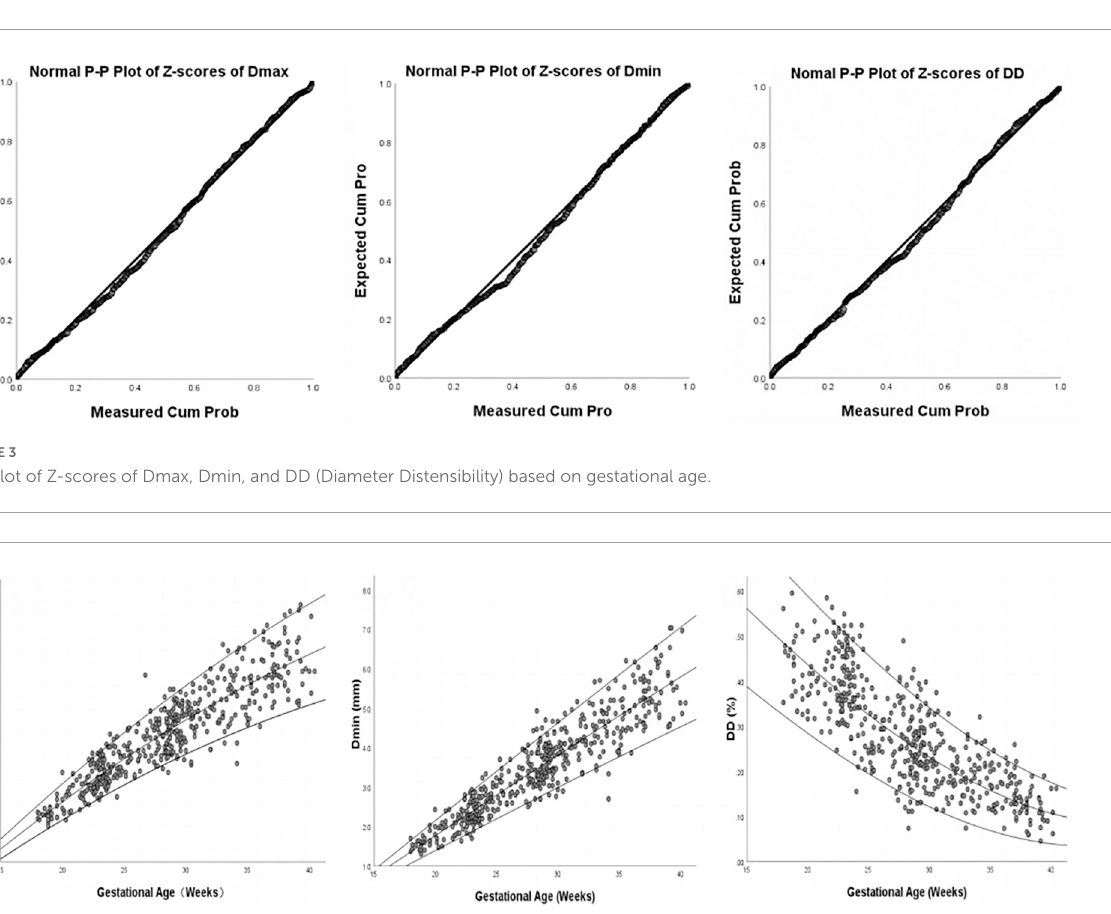
FIGURE4 Scatter plot of Dmax, Dmin, and DD (Diameter Distensibility) based on gestational age ( n = 490), with the 5th, 50th, and 95th percentiles superimposed.